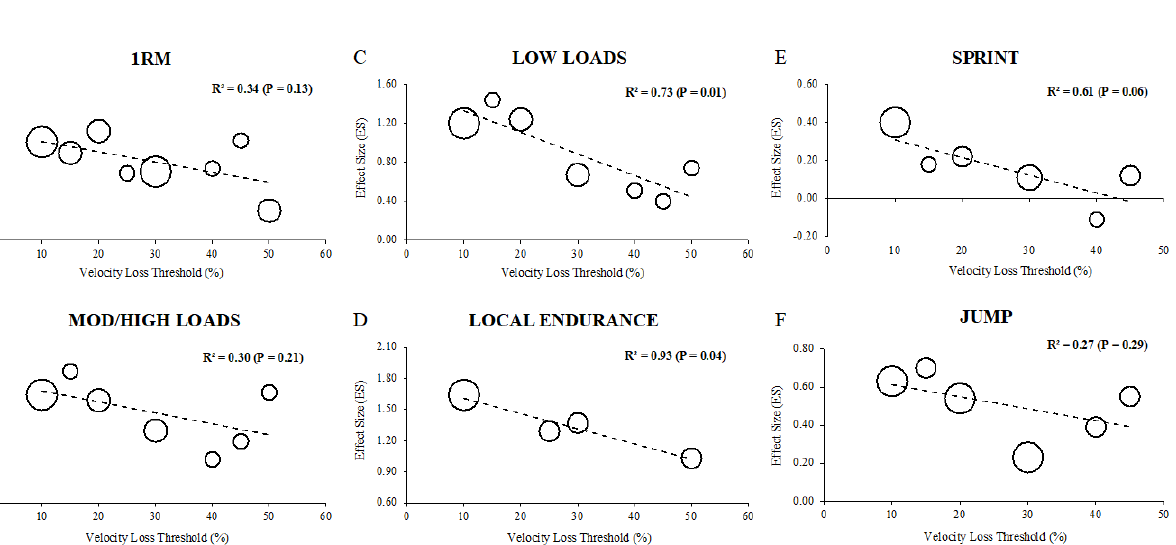
Figure 7. Between-group analysis comparing the effects of Low-Mod VL (≤25% intra -set VL) and Mod-High VL (>25% intra- set VL) to promote changes in jump capacity. Green squares: ES for each individual comparison; Black diamond: pooled ESs. Sánchez-Moreno et al. [31]; Pareja-Blanco et al. [35,37,38]; Rodríguez-Rosell et al. [34,40].